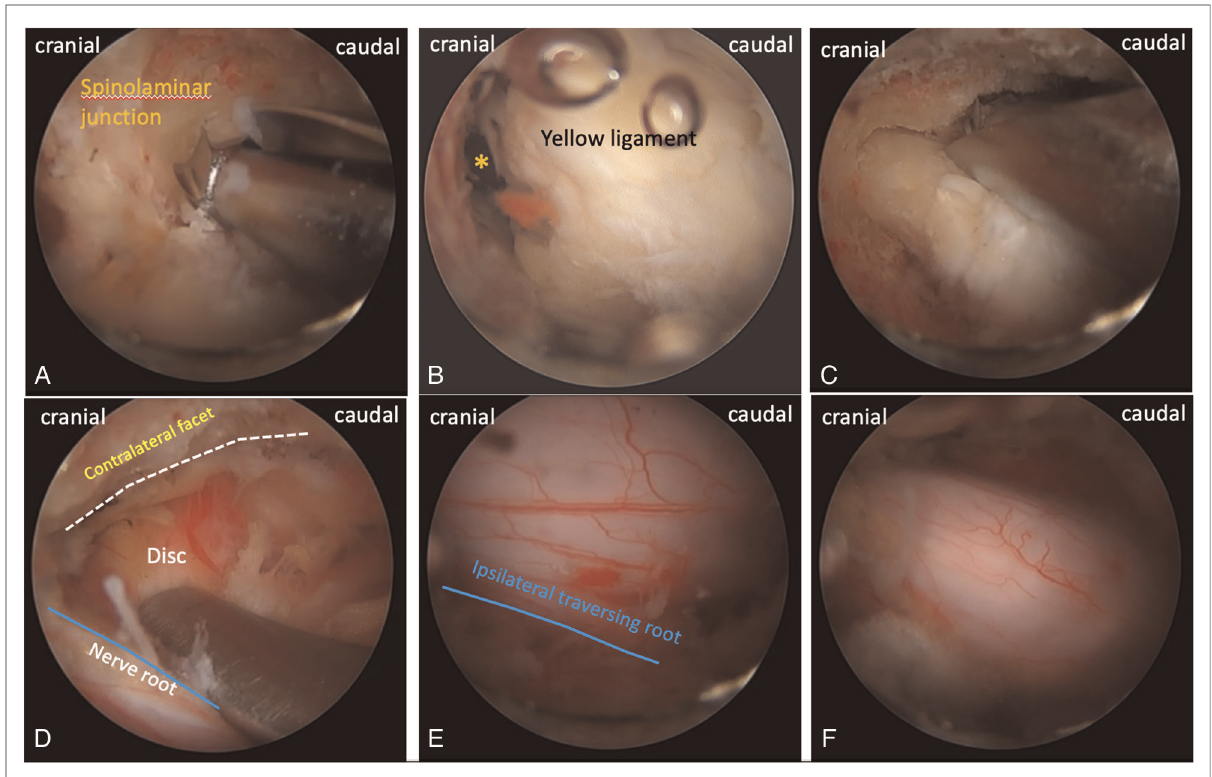
FIGURE 2 Intraoperative endoscopic images. ( A ), drilling from spinolaminar junction. ( B ), * origin of ligamentum fl avum. ( C ), contralateral sublaminar drilling. ( D ), contralateral facet and disc. ( E ), the margin of the ipsilateral nerve root. ( F ), the fi nal view of decompression.